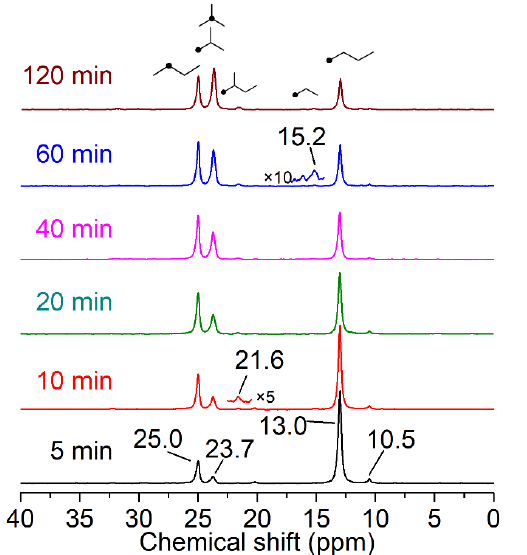
Figure 6. 13 C MAS NMR spectra of 1- 13 C- n -butane reacted at 433 K with M-SZ-2 as the catalyst at different times. Table 3. The conversion and product distribution of the butane isomerization at 433 K for 60 min. Catalysts